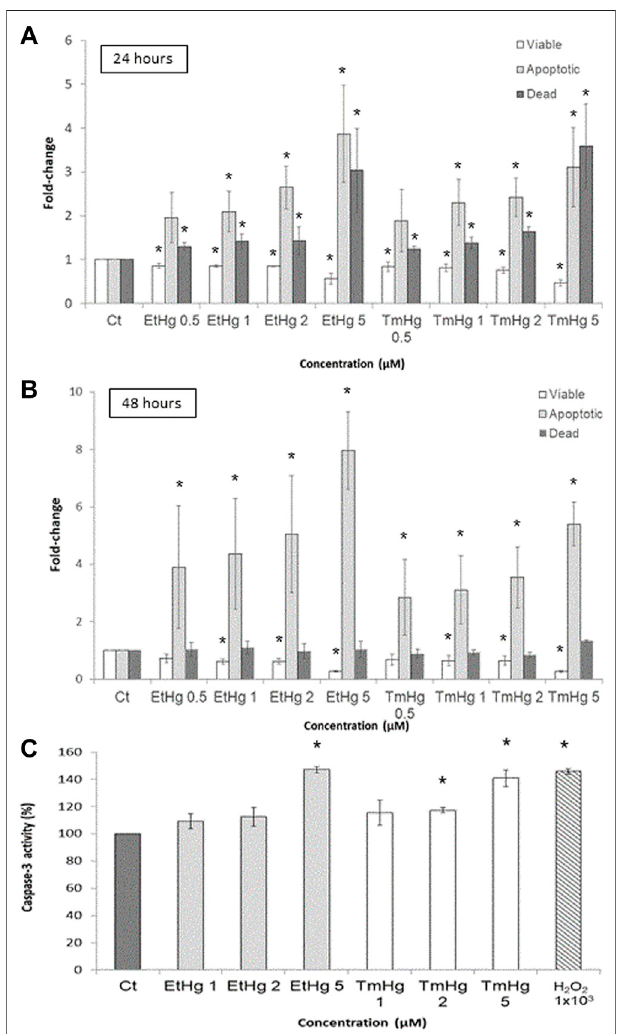
FIGURE 5 | Cytotoxicity effects of EtHg and TmHg at GL261 mouse glioblastoma cells. Flow cytometry Guava ViaCount assay and Caspase-3 determination. The number of apoptotic cells following 24 (A) and 48 h (B) of treatmentatdifferentconcentrationsofTmHgandEtHgwasdetermined by the Guava ViaCount assay. Results are expressed relative to the non- treated control as the mean ± SEM of three experiments p p < 0.05 from the non-treated control. The activity of caspase-3 was also analyzed (C) by DEVD-pNA assay, where cells were exposed for 24 h to 1, 2, and 5 µM of EtHg and TmHg. Exposure to 1 mM H 2 O 2 was used as a positive